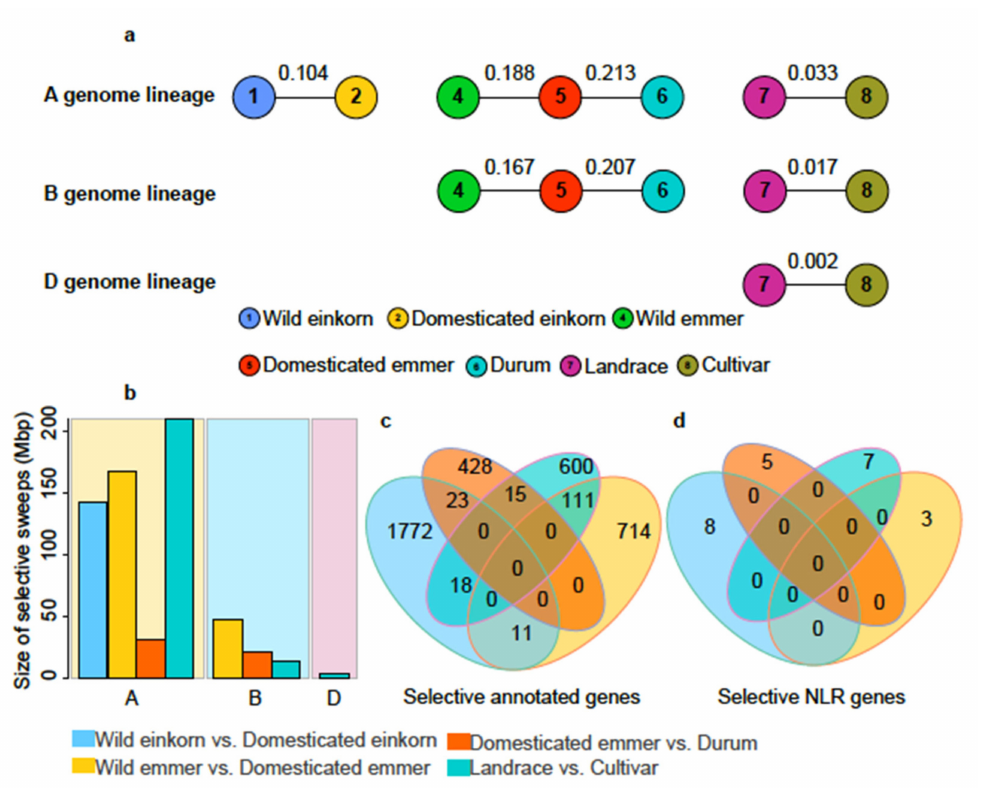
Figure 5. The genetic differentiation ( Fst ) between two groups and the identification of selective sweeps. ( a ) The evaluation of genetic differentiation between two groups using Fst values. Circles with number represent the different groups. The values on the lines represent the Fst values; ( b ) the size of selective sweeps in the A, B, and D genomes from four comparisons; ( c ) the overlapped annotated genes among four comparisons; ( d ) the overlapped NLR genes among four comparisons. Blue represents wild einkorn vs. domesticated einkorn; yellow represents eild emmer vs. domesticated emmer; red represents domesticated emmer vs. durum; green represents landrace vs.